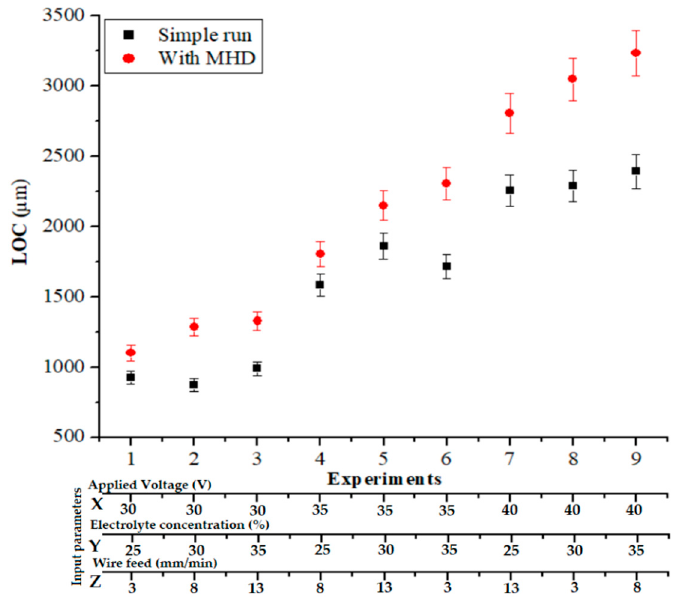
Materials 2021 , 14 , x FOR PEER REVIEW Figure 8. LOC ( μ m) with and without using the MHD method. Figure 8. LOC ( µ m) with and without using the MHD method.